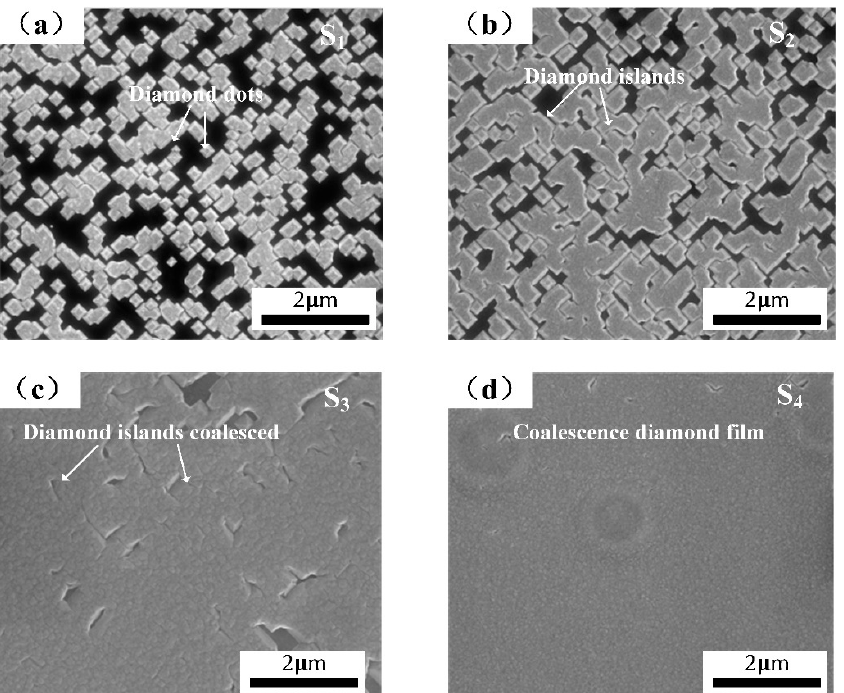
Figure 1. SEM observation of diamond at different growth time after nucleation. ( a ) 5 min; ( b ) 10 min; ( c ) 20 min; ( d ) 40 min.